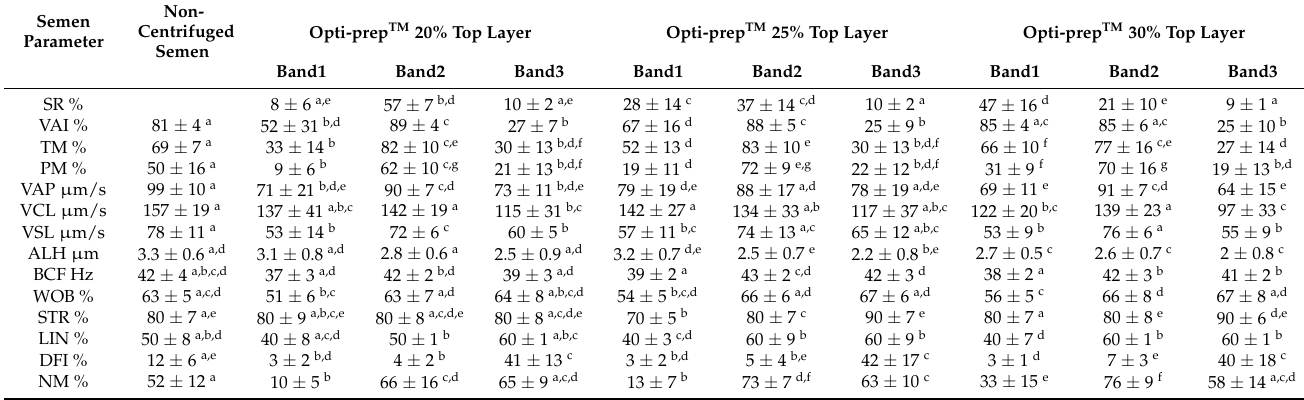
Table 2. Effect of a modified flotation density gradient centrifugation (DGC) protocol on stallion sperm populations. The semen parameters include sperm recovery (SR), viability and acrosome intactness (VAI), total motility (TM), progressive motility (PM), average path velocity (VAP), curvilinear velocity (VCL), straight line velocity (VSL), amplitude of lateral head displacement (ALH), beat cross-frequency (BCF), wobble (WOB), straightness (STR), linearity (LIN), DNA fragmentation index (DFI) and normal morphology (NM) before and after centrifugation by the modified flotation DGC (diluted semen mixed with Opti-prep TM 60% and layered between the top layer and a 40% Opti-prep TM bottom layer). Within a row, values with different superscript letters differ significantly ( p ≤ 0.05, n = 7